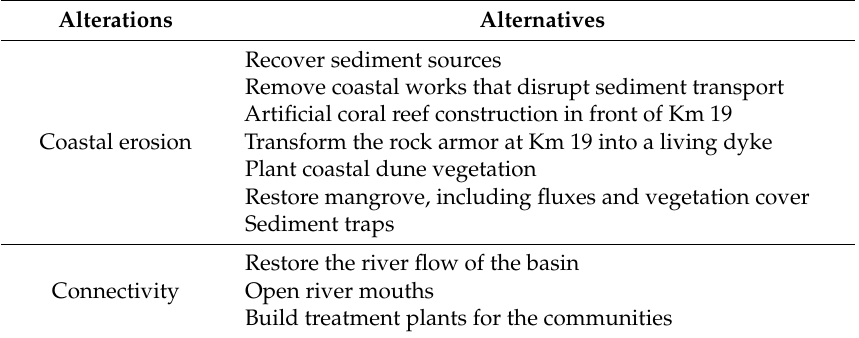
Table 4. Alternatives to restore the resilience of